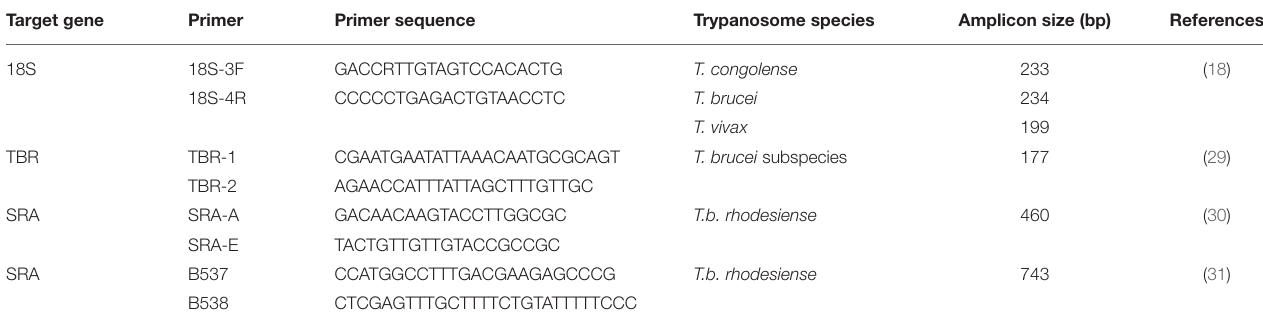
TABLE 1 | List of primers used for trypanosome species and SRA gene identification. Target